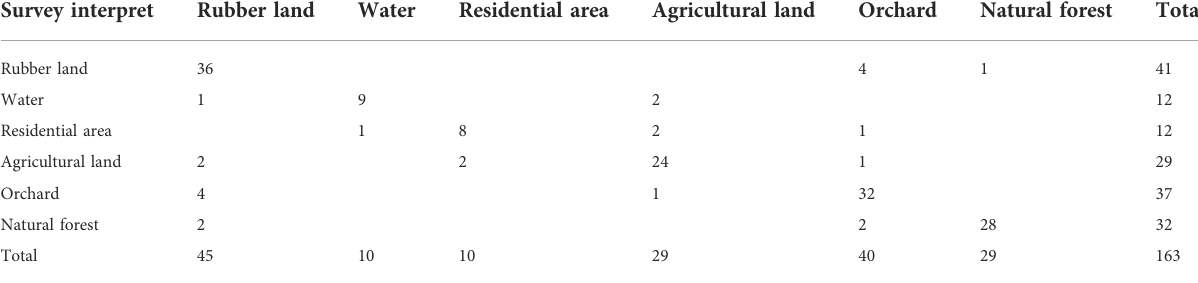
TABLE 1 Comparison land-use types between remote sensing interpreting results and fi eld survey. Survey interpret Rubber